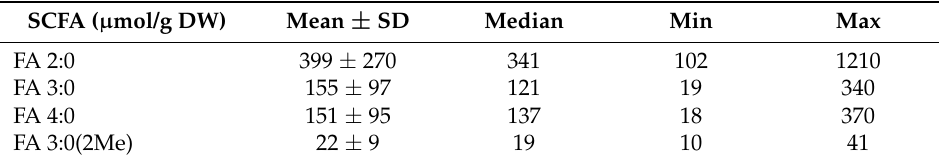
Table 3. SCFAs concentrations in human feces. Displayed are the SCFAs concentrations determined for the fecal samples of 22 volunteers.